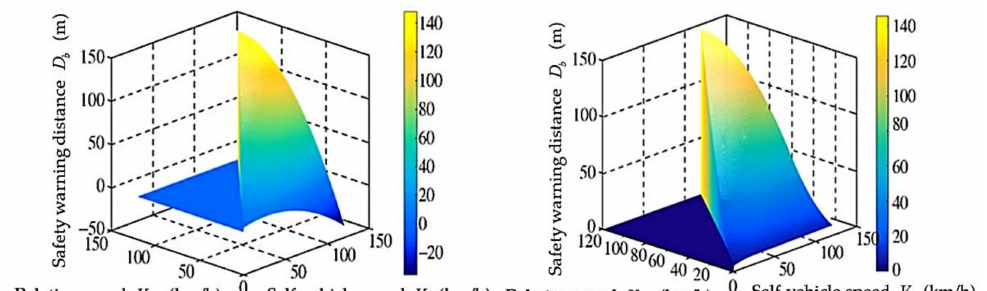
Figure 19. Comparison of the early warning distances of the improved Berkeley model. The lateral safety distance model of the curve is simulated based on MATLAB, as shown in Figure 20.